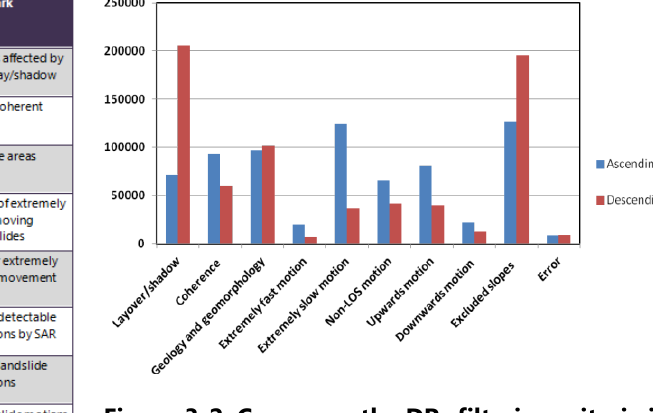
Figure 3-2: Compares the DPs filtering criteria in ascending and descending orbits.